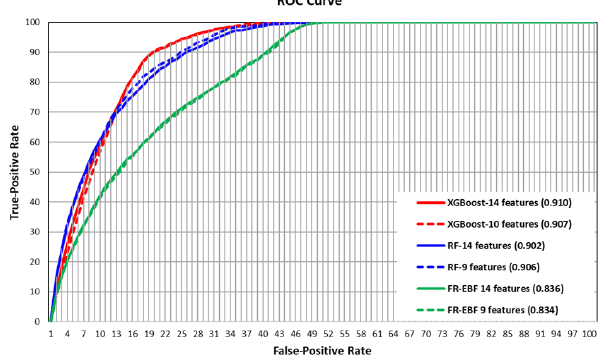
Figure 10. Feature importance of the RF and XGBoost models (hor- izontal red line shows 0.3 as the cut-off value).